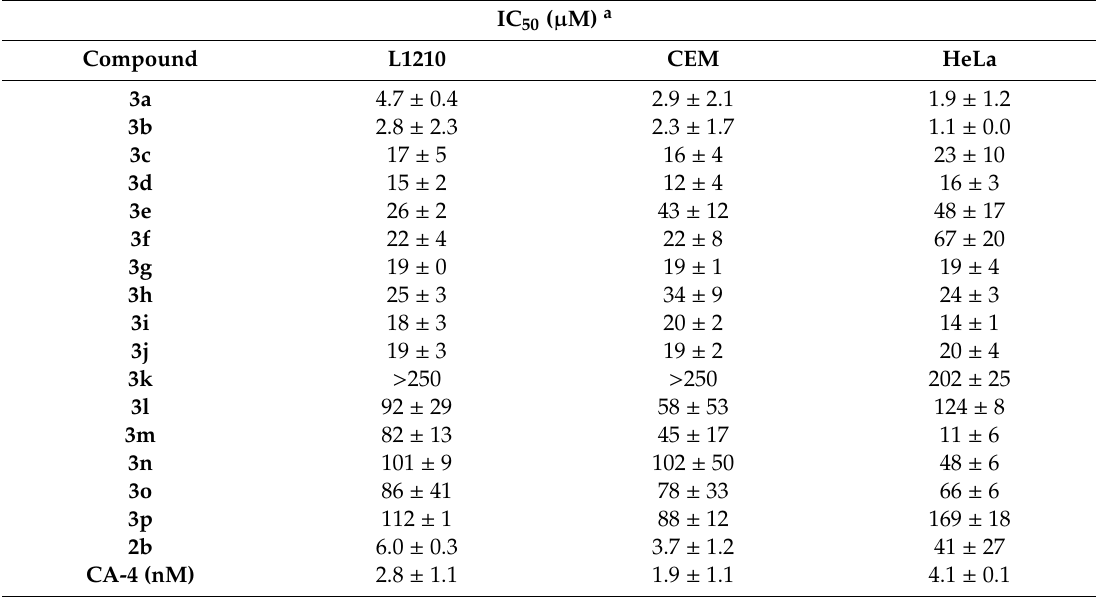
Table 1. In vitro growth inhibition activity of compounds 3a – 3p and reference compounds 2b and CA-4 against the proliferation of murine leukemia (L1210), human T-lymphocyte (CEM), and human cervix carcinoma (HeLa)